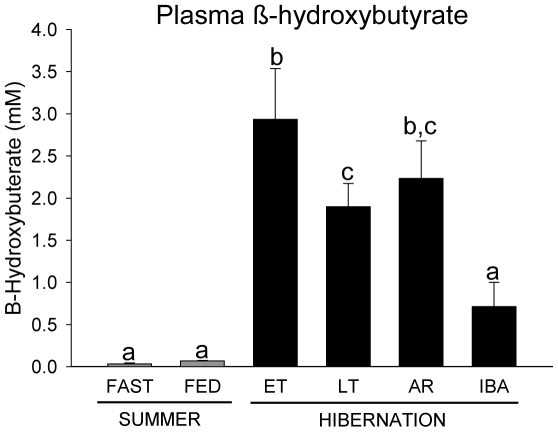
Plasma β-hydroxybutyrate (BHB) concentration over the annual hibernation cycle.BHB concentrations in fasted and fed spring (SPR) (open bars) and summer (SUM) (grey bars) squirrels, and in hibernators (filled bars) during early torpor (ET), late torpor (LT),arousing (AR), and interbout arousal (IBA) squirrels are shown. Groups with the same letter are not different. All values represent means ± s.e.m., n = 5 or 6 for all groups.